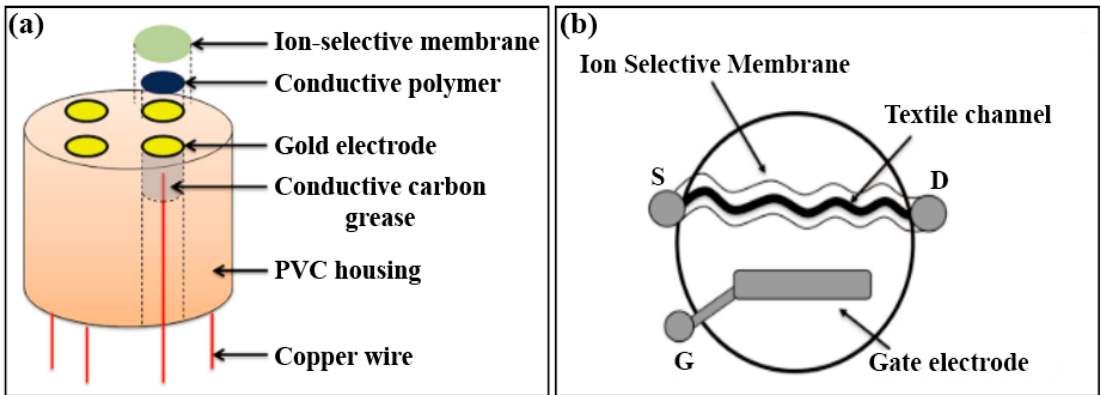
Figure 4. ( a ) Schematic illustration showing the architecture of working electrode for multiple ion sensing [47]; ( b ) sketch of a OECT type sensor fabricated with textile channel coated with ion selective membrane [44].